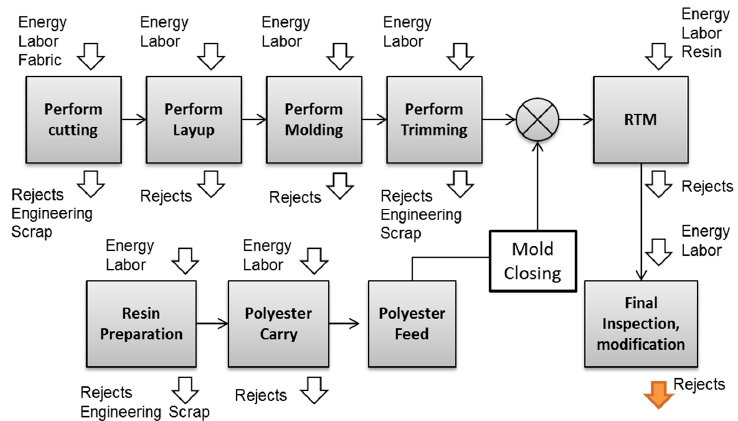
Figure 2. Resin Transfer Molding (RTM) process cost model step sequence in Ancel’s workshop.